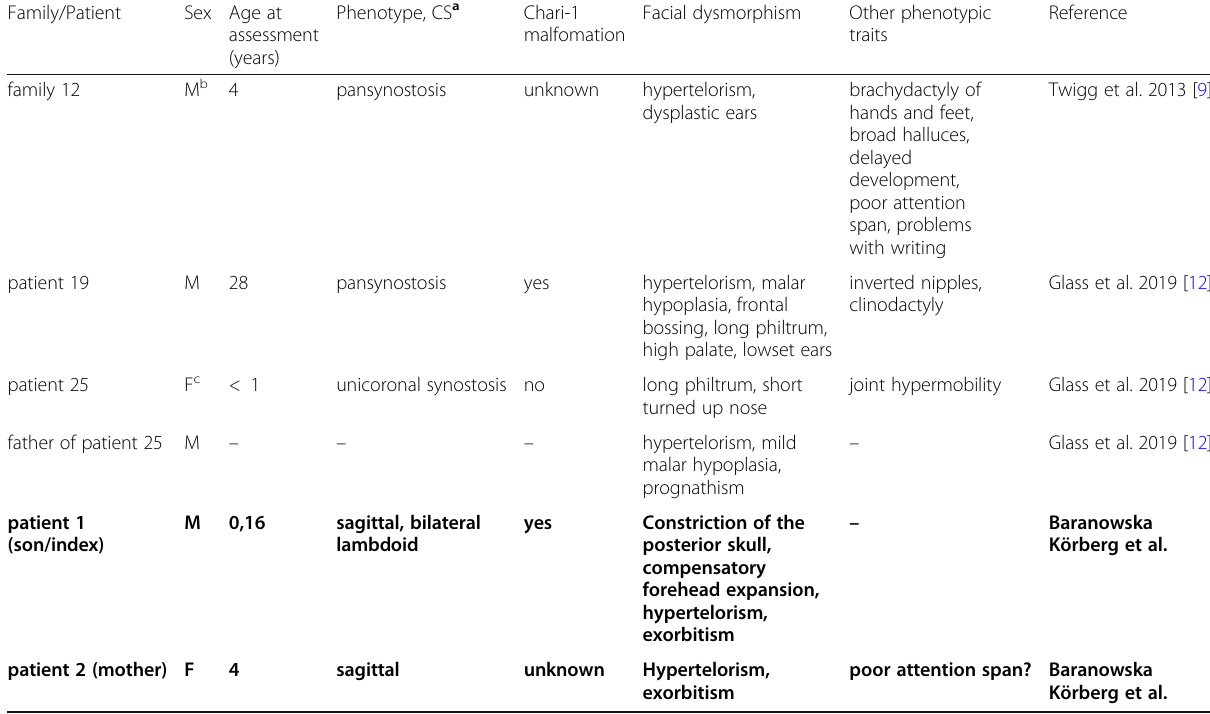
Table 1 Overview of the clinical features of ERF variant c.1201_1202delAA p.Lys401Glufs*10 as reported by Twigg et al. 2013, Glass et al. 2019 and the present